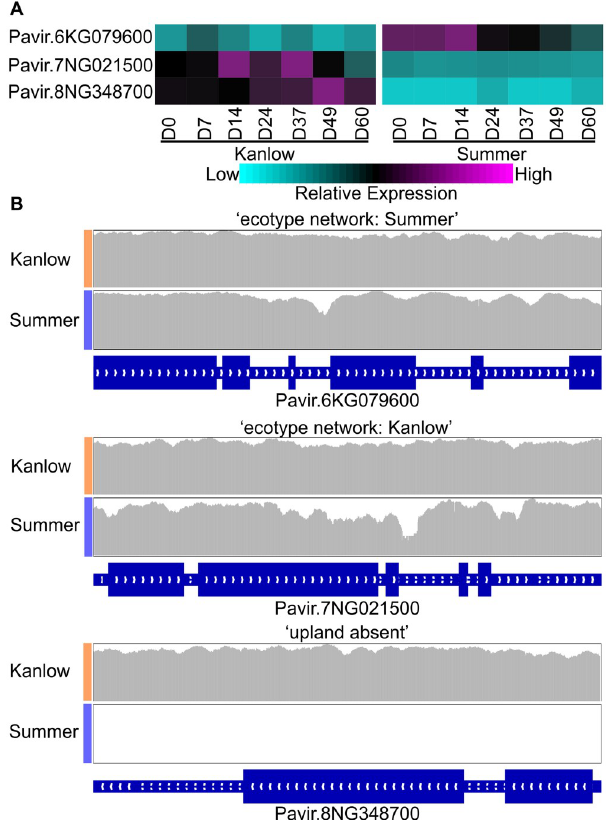
Fig 7. Expression heatmap and genomic coverage of three select NB-LRR genes. (A) Expression heatmap and (B) Genomic coverage evidence used for the ‘ecotype network’ or ‘Summer absent’ classification of NB-LRRs in Kanlow and Summer genomes. Gene models were obtained from Phytozome (https://phytozome.jgi.doe.gov/pz/portal.html#! info?alias=Org_Pvirgatum_er). Introns and exons are shown as narrow or wide rectangles respectively.